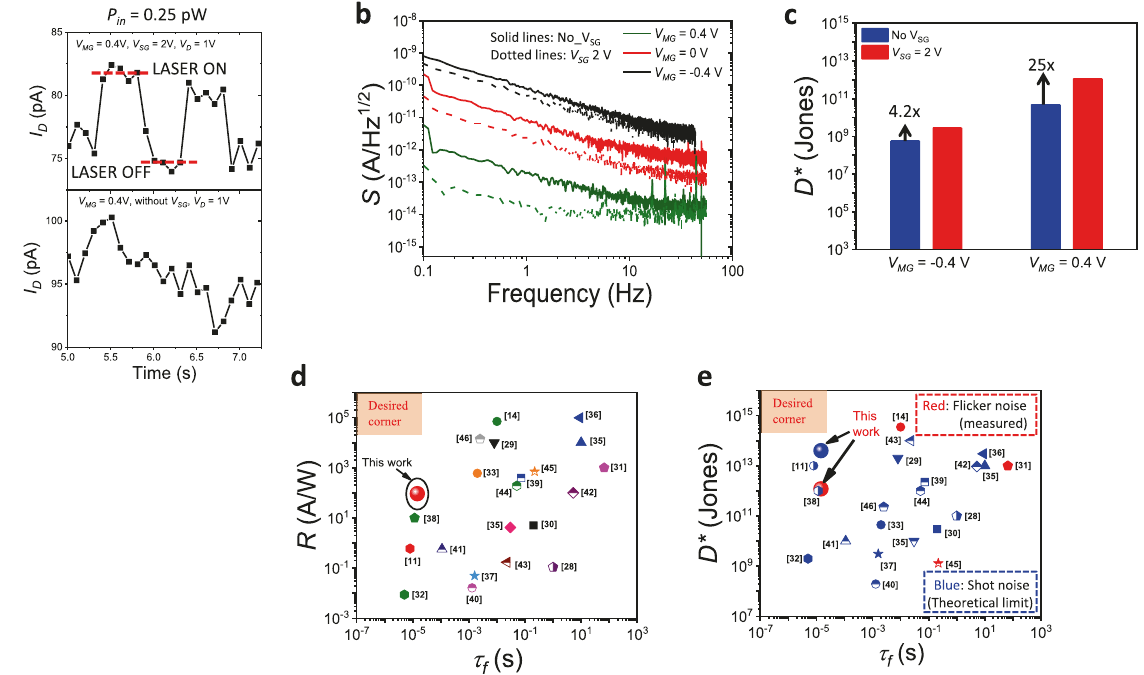
Fig. 6 Measured noise, detectivity, and benchmarking of WSe 2 phototransistor. a . Photoswitching observed for V SG = 2 V at an ultra-low laser power of 0.25 pW, unlike the No-V SG case. b Noise power spectral density ( S ) from fl icker noise measurement for No-V SG and V SG = 2 V shows lower noise fl oor (by nearly 10x) for V SG = 2 V. c Speci fi c detectivity ( D* ) at V MG = ± 0.4 V for No-V SG and V SG = 2 V shows 25x enhancement in D* with V SG . Benchmarking plots of ( d ) R and ( e ) D* vs fall time ( τ f